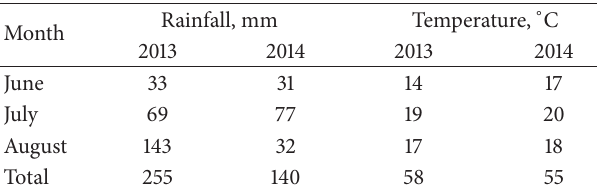
Table 1: Monthly rainfall and air temperatures for 2013 and